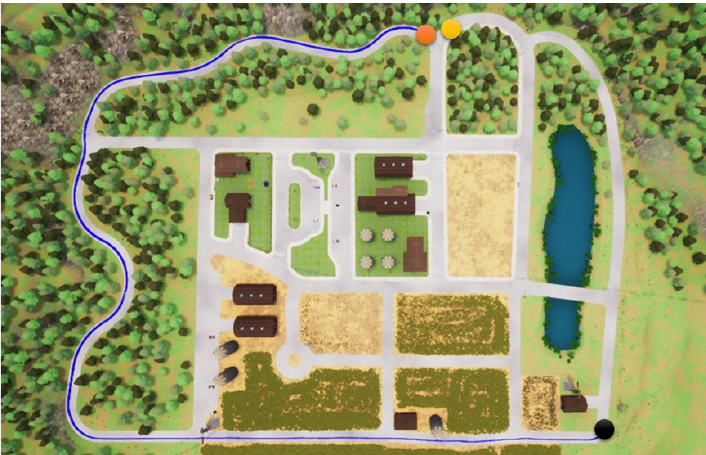
Figure 16. DDPG with an RGB camera for the second testing path.